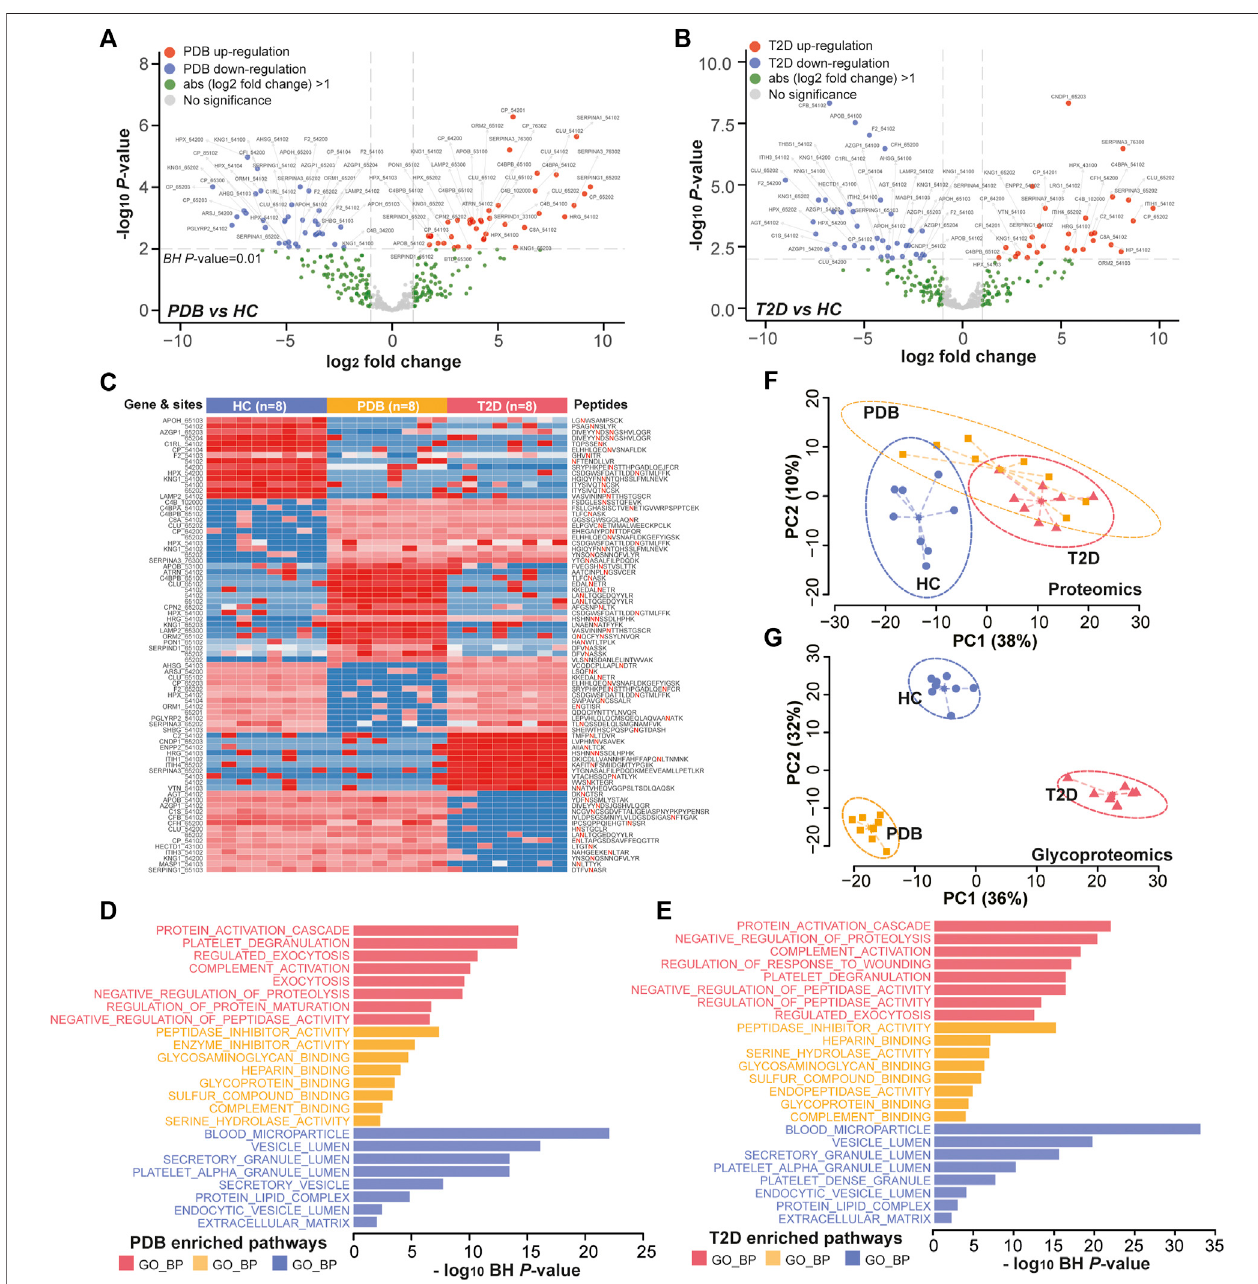
FIGURE5| GlycoproteomicalterationsinT2DpatientsandPDBsubjects. (A,B) VolcanoplotsofdifferentialexpressedN-glycopeptidesidenti fi edinPDBsubjects (A) or T2D patients (B) or compared to HC individuals. Red presents upregulation and blue indicates downregulation. Signature proteins were determined based on a Benjamin – Hochberg corrected p -value < 0.01 and an absolute log2-fold change ≥ 1. (C) Heatmap depicting the relative abundance of signature N-glycopeptides. Samplesareincolumnsandpeptidesareinrows.Thegenenamesandglycancompositionnumbersareannotatedontheleftpanel,andthepeptideinformationis annotatedontherightpanel. (D,E) GOenrichmentresultsofthemappedproteinsofsignatureN-glycopeptidesforPDB (D) andT2D (E) groups. (F,G) PCAplotsof fi rst two components of signature proteins (F) and N-glycopeptides (G) . The ellipse presents the 0.95 con fi dence intervals for each type.